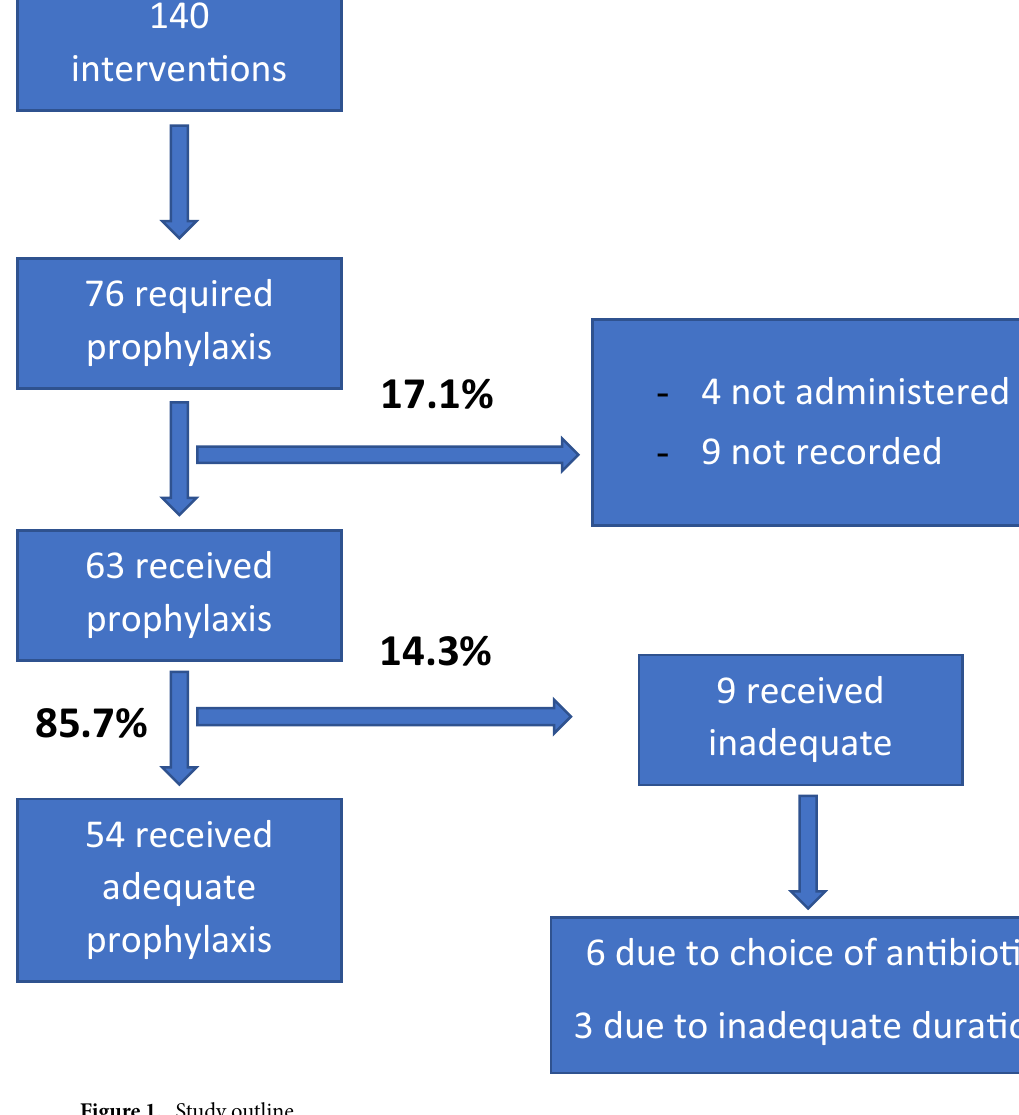
Figure 1. Study outline.